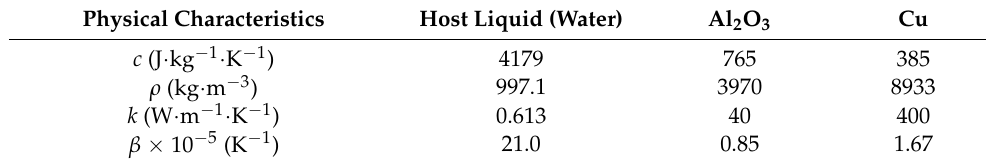
Table 1. Thermophysical properties of fluid (at 25 ◦ C) and nanoparticles [45,52,54]. Physical